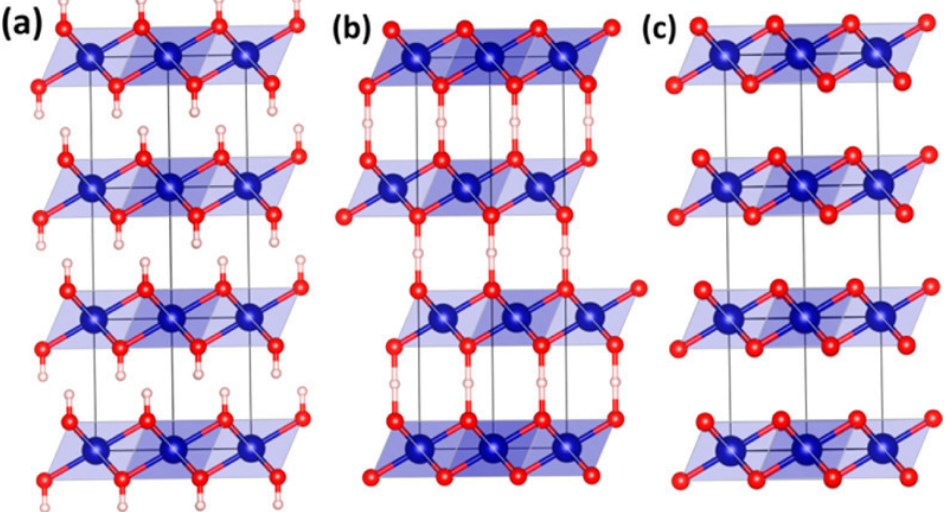
Figure 34. Layer structure of ( a ) Co(OH) 2 , ( b ) CoO(OH), and ( c ) CoO 2 . The main difference among these structures is the number of protons between the CoO 2 layers. (Reprinted from ref. [199] with permission from The Journal of Physical Chemistry C © 2013, American Chemical Society).